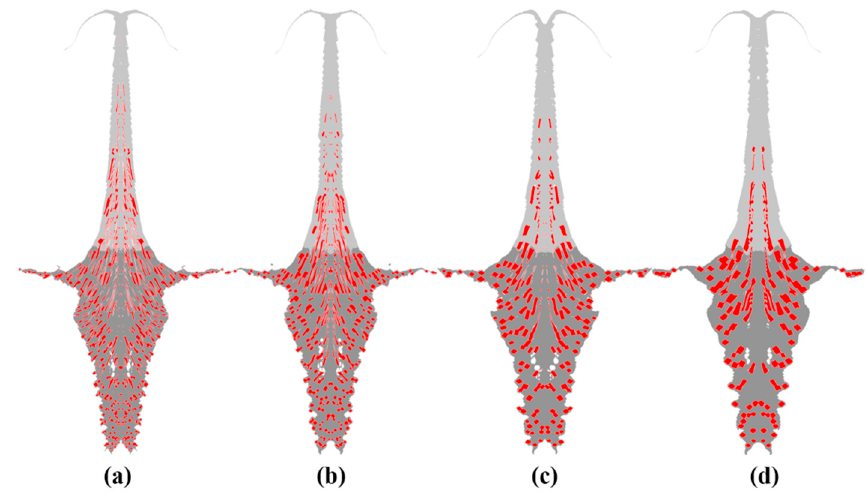
Figure 12. Geometrical morphology of jets formed by Al granules of different average size at 2 CD